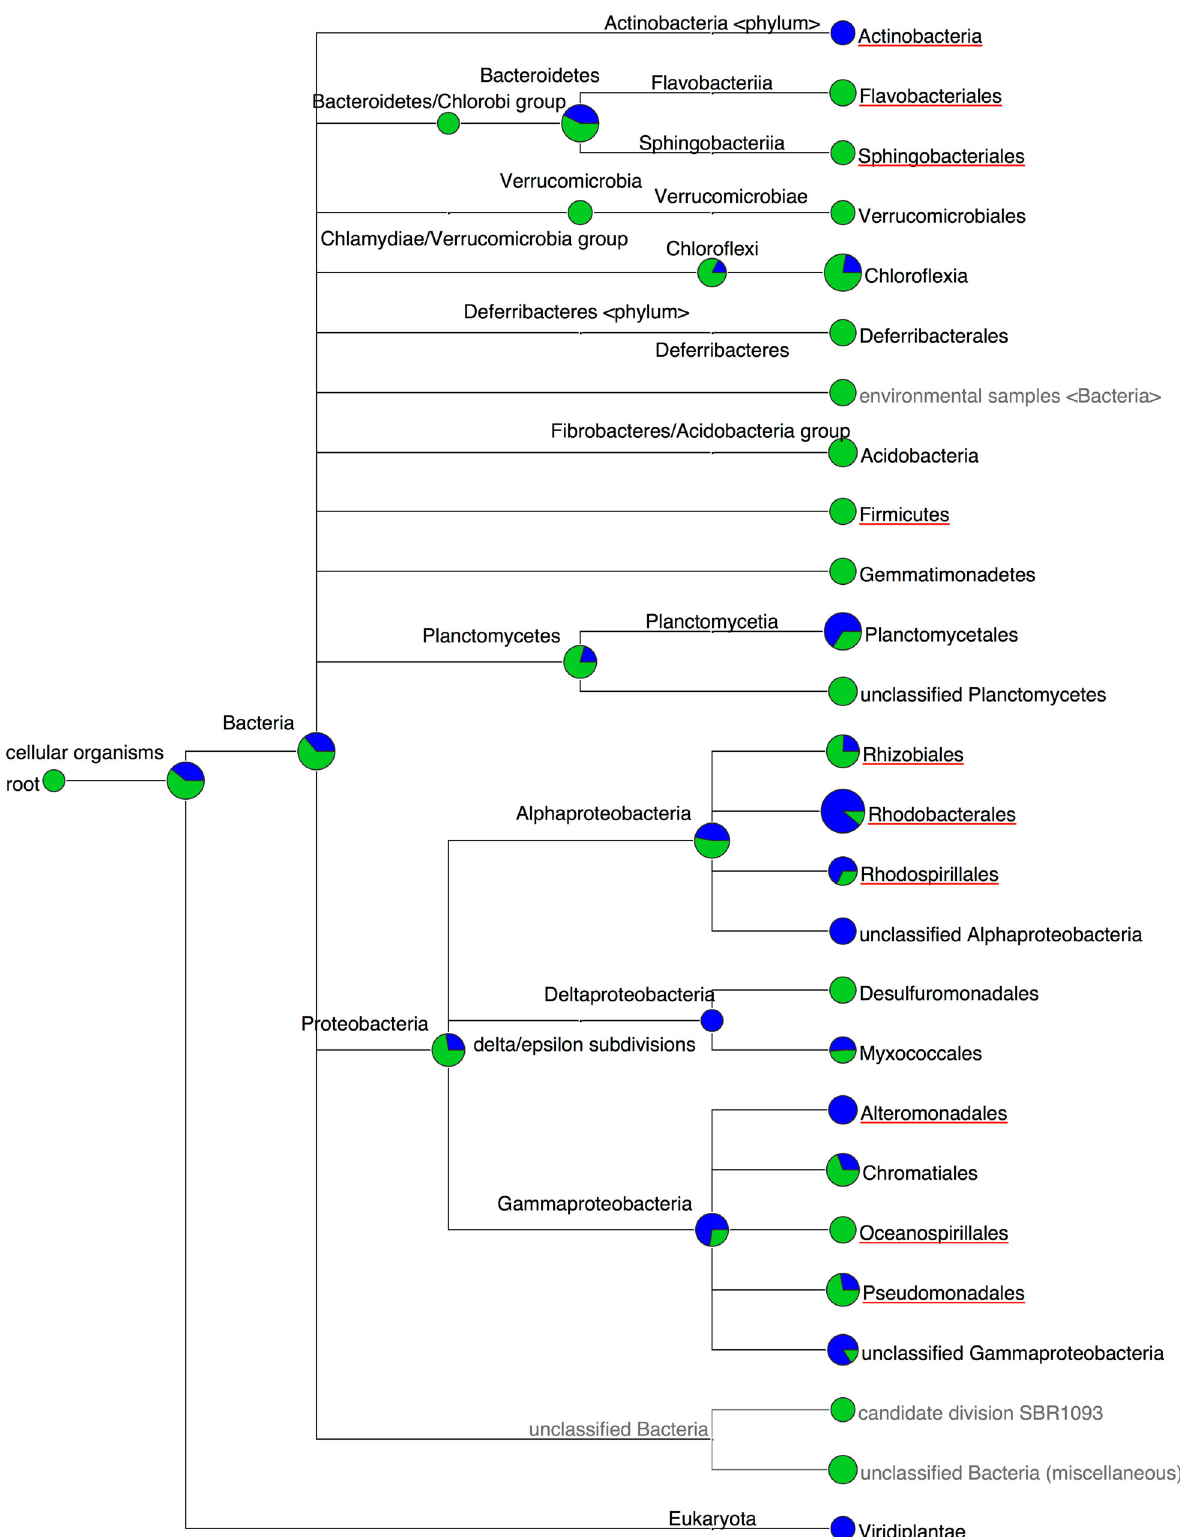
Fig. 1 MEGAN cladogram representing the bacterial community composition of feed-water ( green dots ) and polished seawater ( blue dots ) from the Perth Seawater Desalination Plant. The underlined taxa represent bacterial orders that were present in the RO-membrane bio fi lm